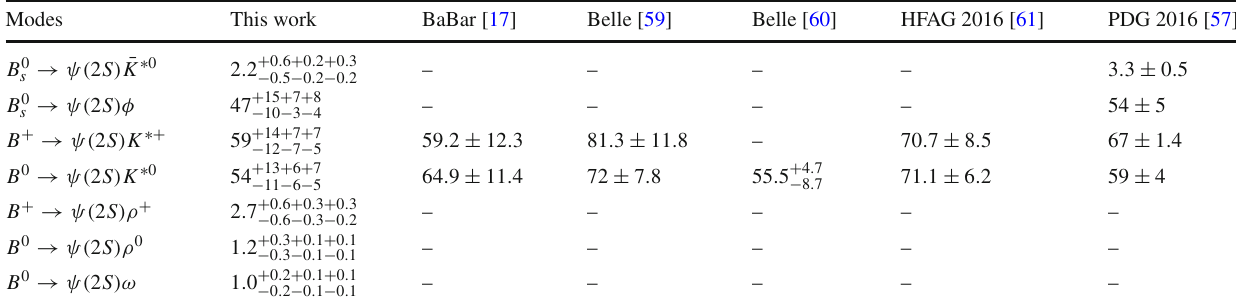
Table 2 The pQCD predictions for the CP-averaged branching ratios for the B → ψ( 2 S ) V decays (in units of 10 − 5 ). For comparison, experimental results from BaBar [17], Belle [59,60], or the world average from HFAG 2016 [61] and PDG 2016 [57] are also listed Modes This